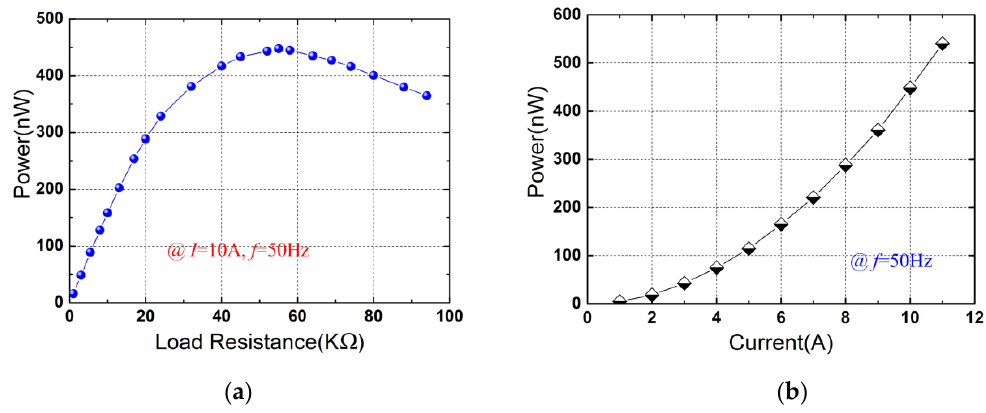
Figure 8. Output powers for energy harvesting application: ( a ) Output power as a function of load resistance for I = 10 A; ( b ) Maximal power versus electric current at the frequency of 50 Hz.